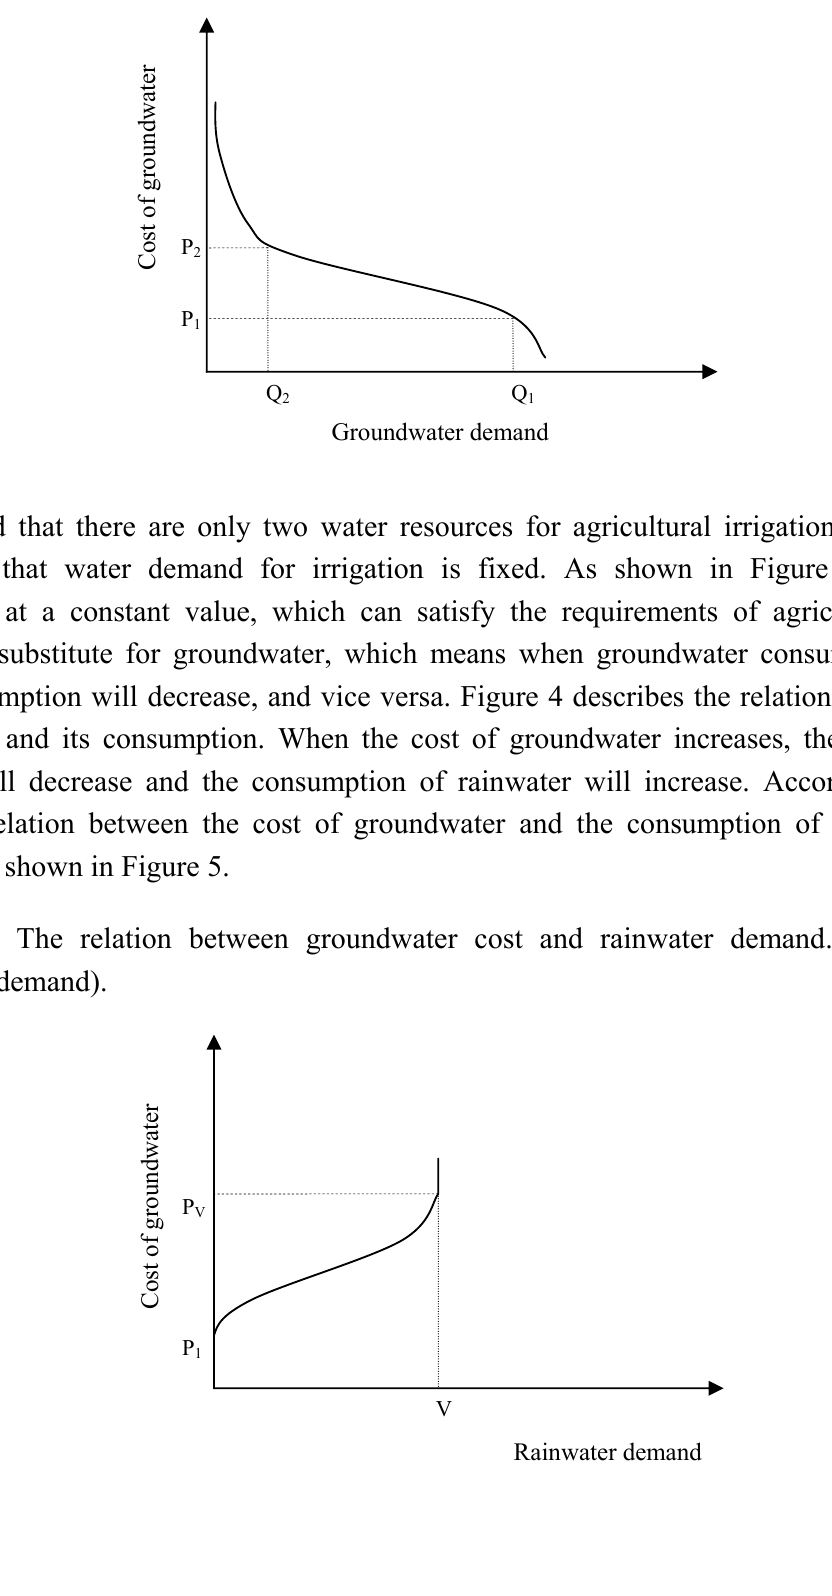
Figure 4. The change in elasticity of groundwater in terms of different costs. (P means cost of groundwater; Q means groundwater demand).